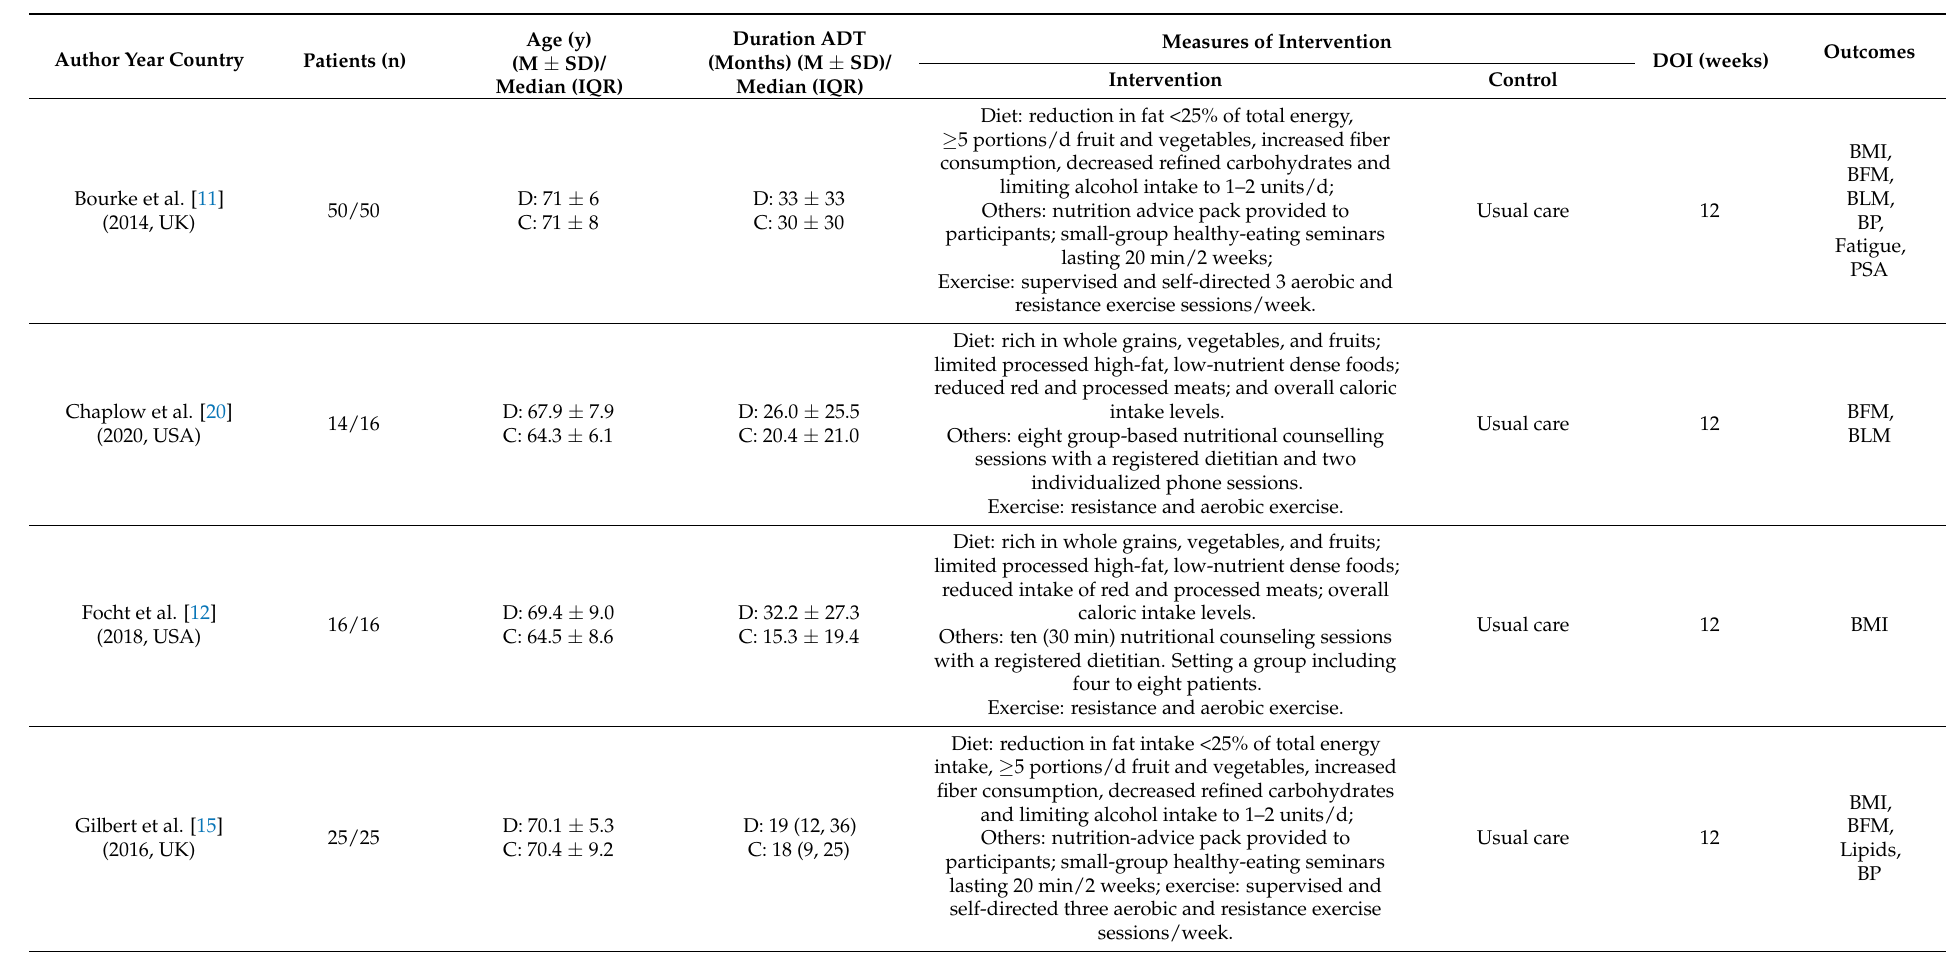
Table 1. Baseline characteristics of included